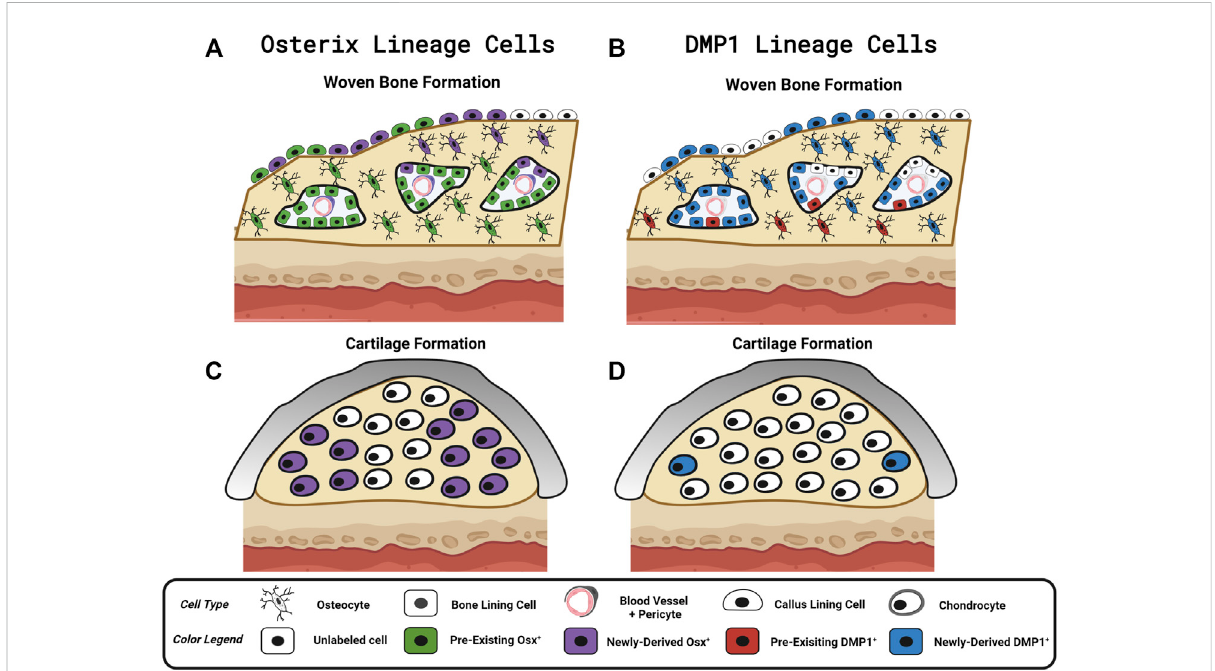
FIGURE 8 Contribution of Osx and DMP1 Cell Lineages to Bone Repair. Model depicting pre-existing (Pulse TMX) and newly-derived (Continuous TMX) OsxandDMP1celllineagecontributionstowovenboneandcartilageformationinresponsetoboneinjury. (A) Followingfullfracture,stressfracture, and cortical defect pre-existing Osx + lineage cells and their progeny (Green) readily become callus lining cells (expanded periosteum), osteocytes andbone liningcells innewwovenbone adjacent to thecortical bone surface. Newly-derivedOsx + lineage cells (Purple) then makeuptherest of the woven bone osteocytes and woven bone lining cells, including the high cellularity marrow spaces, within the intramembranous ossi fi cation region. (B) Incontrast,pre-existingDMP1 + lineagecells(Red)sparselypopulatenewwovenbonetissue(i.e.wovenboneosteocytesandwovenbone liningcells).Althoughthemajorityofnewly-derivedpost-fracturewovenboneosteocytesandwovenboneliningcellsgoontoexpressDMP1(Blue), the high cellularity marrow spaces within woven bone (vasculature and pericytes) are not labeled by DMP1 Cre_ERT2. (C) Cells in cartilage regions near thefemoral fracture sitedon ’ t arise frompre-existing Osx + lineagecells ortheir progeny. Withcontinuous tamoxifen dosing,a high percentage ofchondrocytesarelabeledbyOsxCre_ERT2. (D) Cellsincartilageregionsnearthefemoralfracturesitedon ’ tarisefrompre-existingDMP1 + lineage cells or their progeny. However, with continuous tamoxifen dosing, asmall percentage ofchondrocytes express DMP1 (less than Osx + lineage cells). Figure Created in